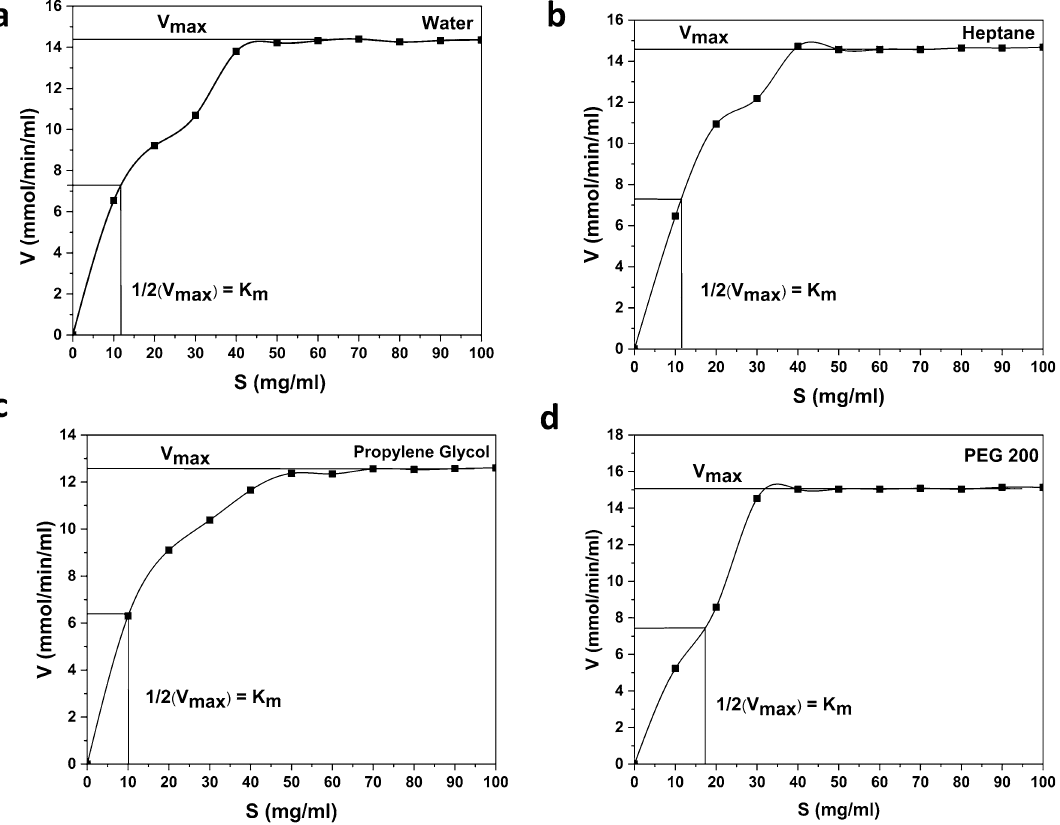
Figure 2. Michaelis–Menten plot of the enzyme substrate reaction (V vs S) ( a ) Control (water), ( b ) Heptane, ( c ) Propylene glycol and ( d ) PEG 200. Reaction was conducted by varying the concentration of starch in the range of 10–100 mg/ml along with 1 ml of enzyme (having activity of 4.6 mmol/min/ml in water, 6.5 mmol/min/ml in heptane, 5.3 mmol/min/ml in propylene glycol and 6 mmol/min/ml in PEG 200) and 1 ml of the respective solvent incubating at 30 °C and at a pH of 6.9 for 10